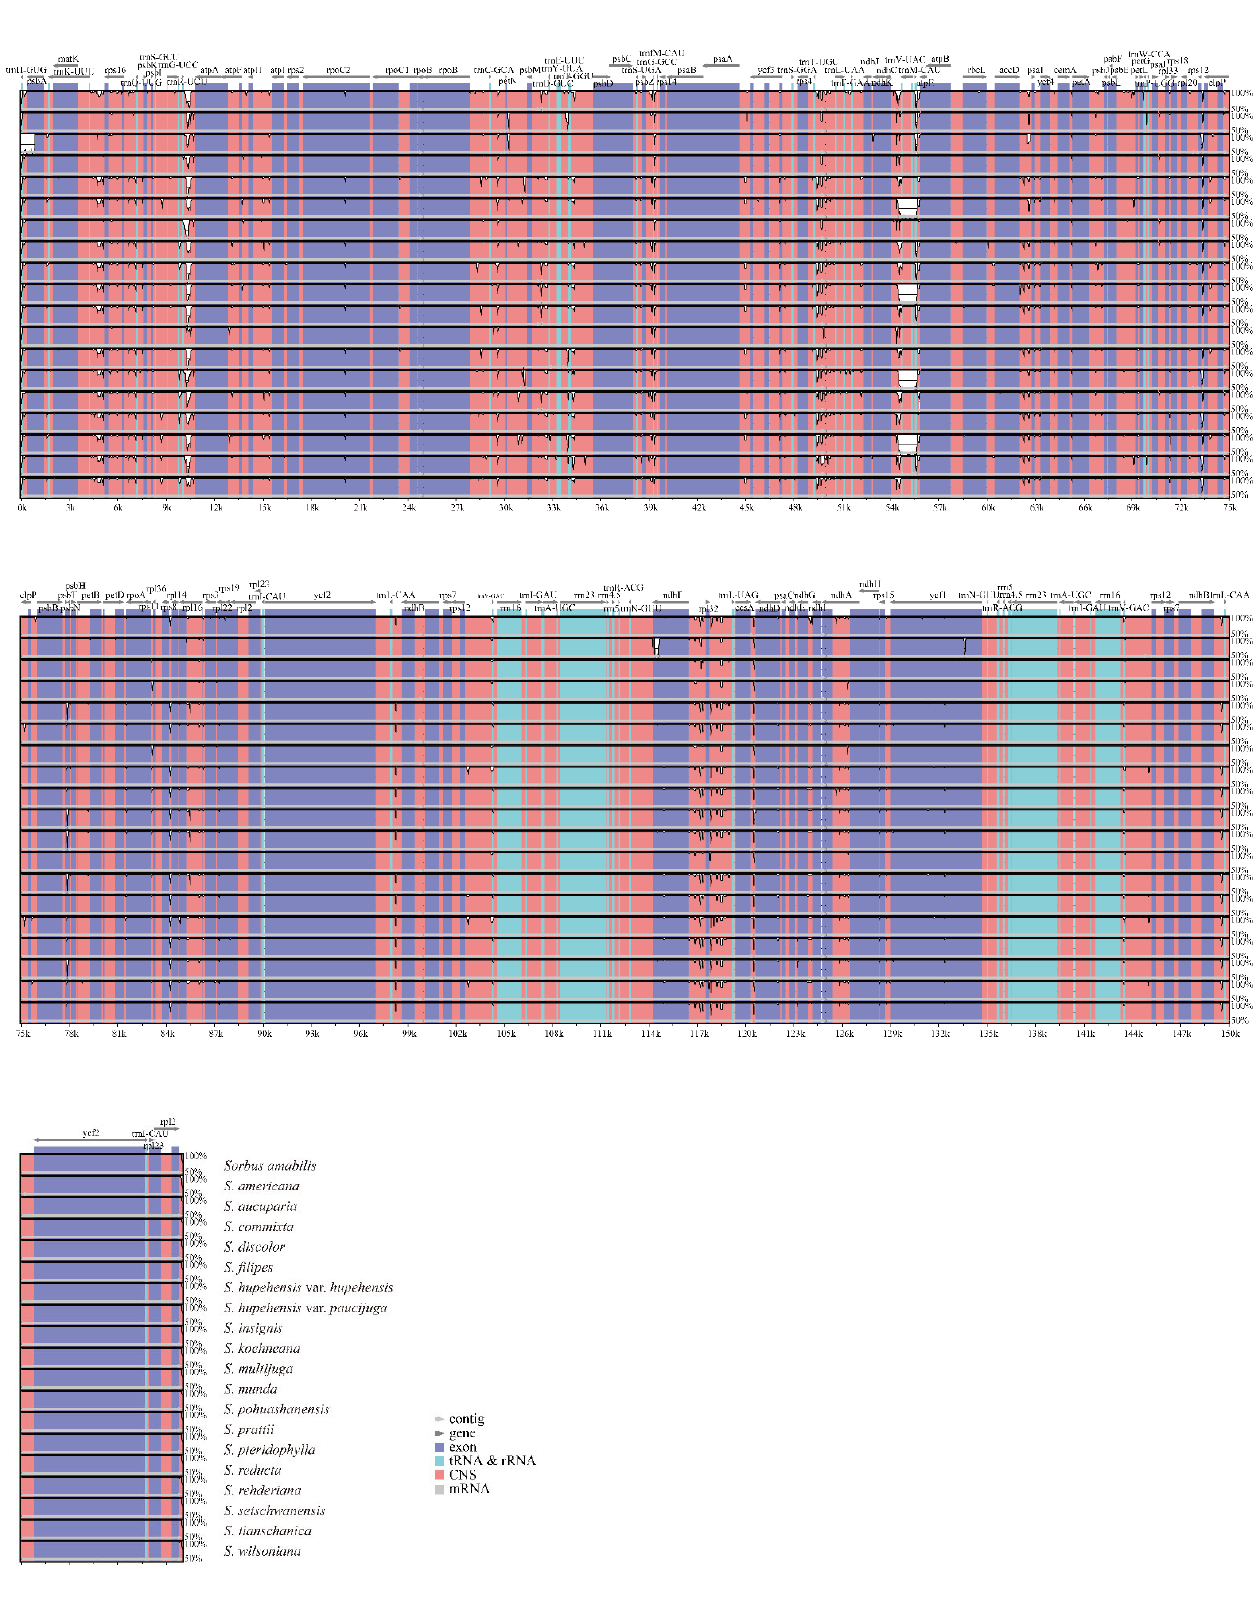
Figure 4. Alignment of 20 Sorbus chloroplast genomes using mVISTA.